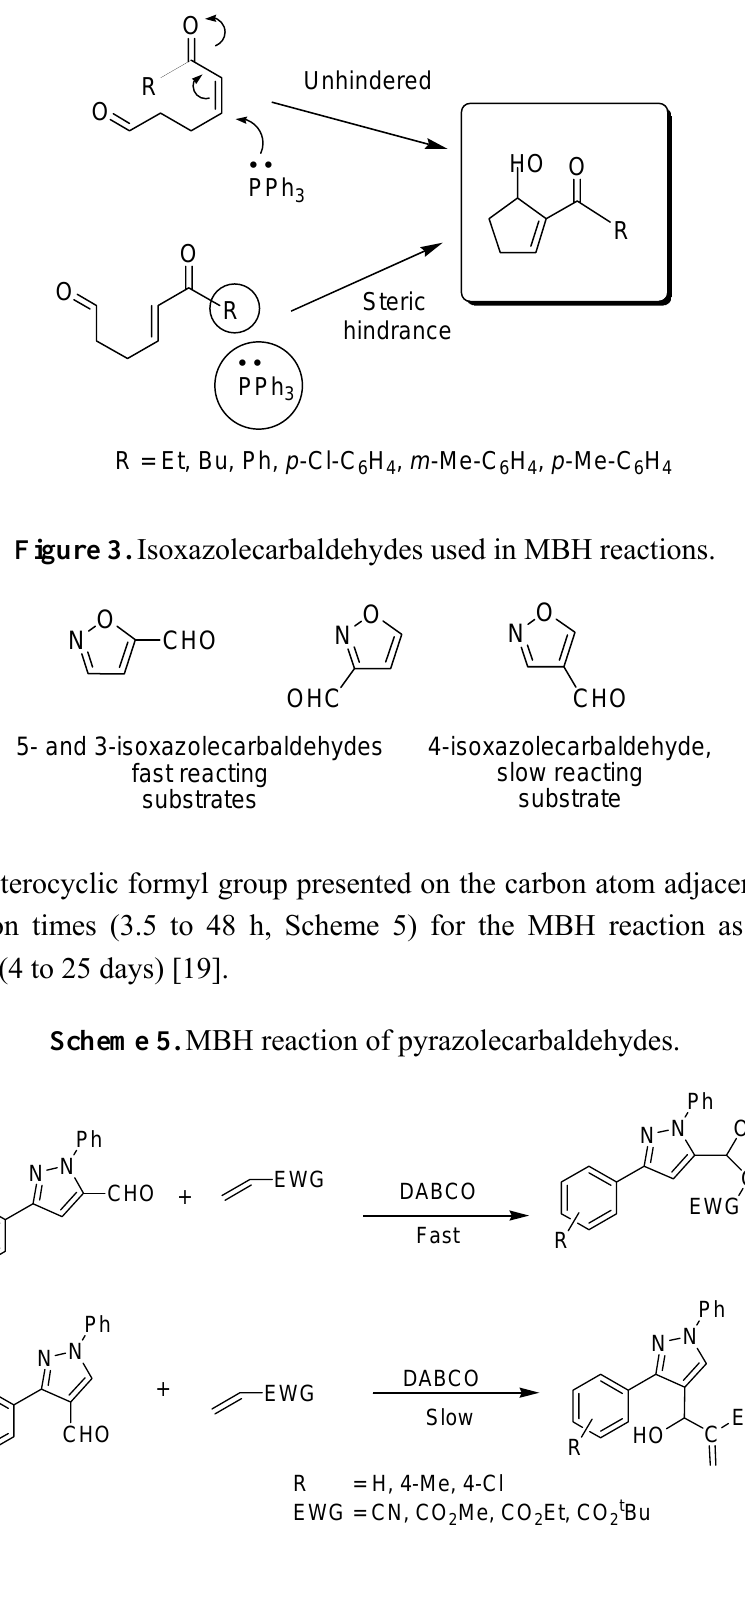
Figure 2. Influence of the stereochemistry of the Michael acceptor in the MBH reaction.